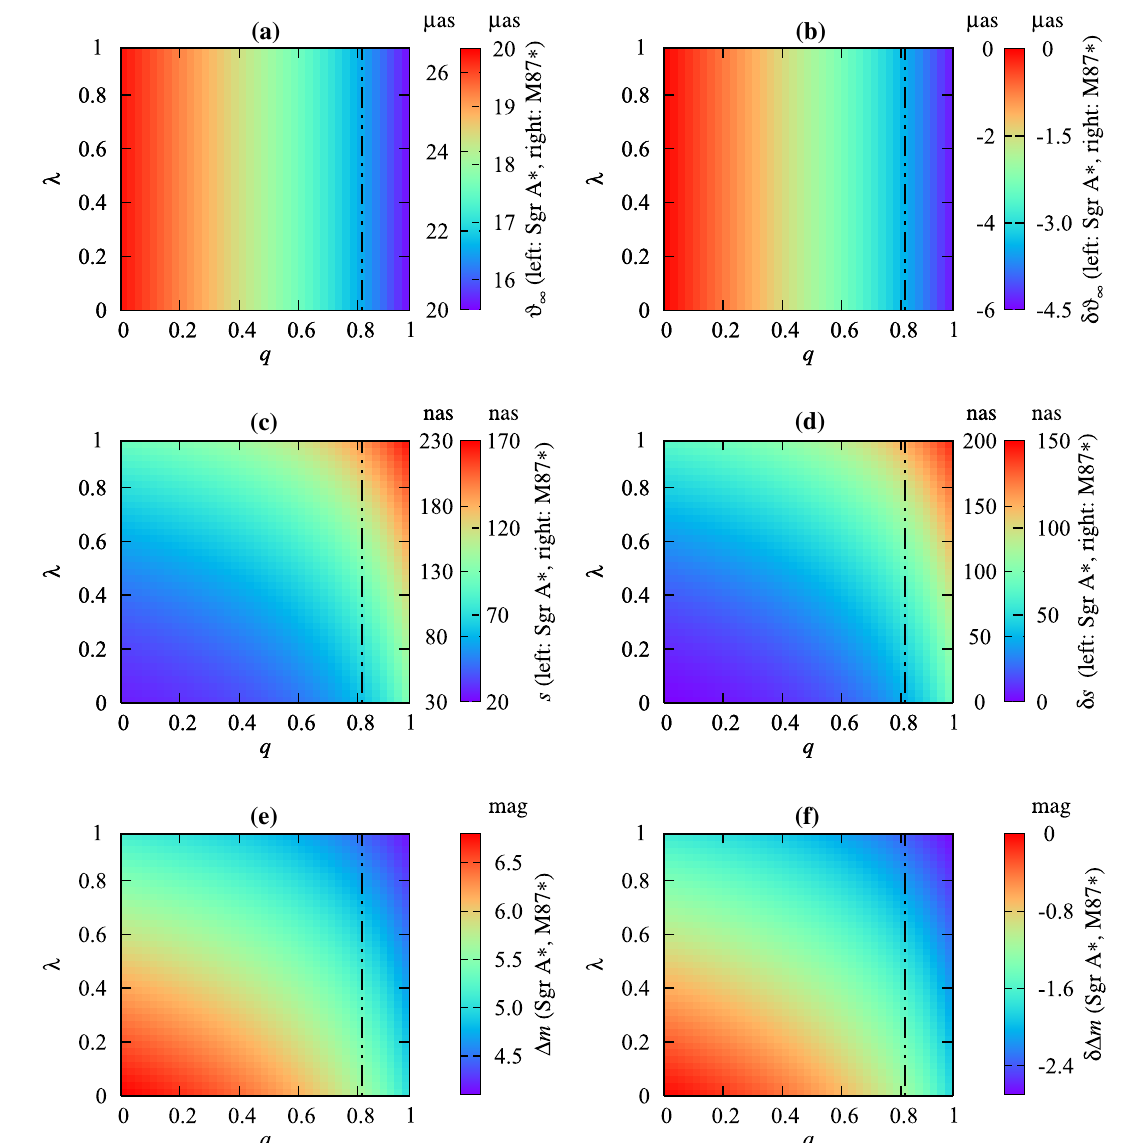
Fig. 8 Color-indexed ϑ ∞ , δϑ ∞ , s , δ s , Δ m and δΔ m in the strong deflection gravitational lensing are shown for Sgr A* and M87* on D H (8). The dash-dotted lines mark the upper bound on q based on the shadow of M87* observed by EHT (10)